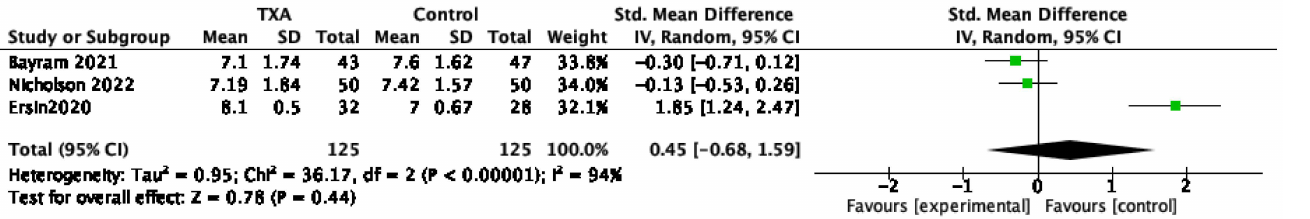
Figure 4. Forest plot and meta-analysis of visual clarity.XA groups. The centre of each square represents the weighted mean differences for individual trials, and the corresponding horizontal line stands for a 95% confidence interval. The diamonds represent pooled results. Legend: CI = confidence interval; SD = standard deviation